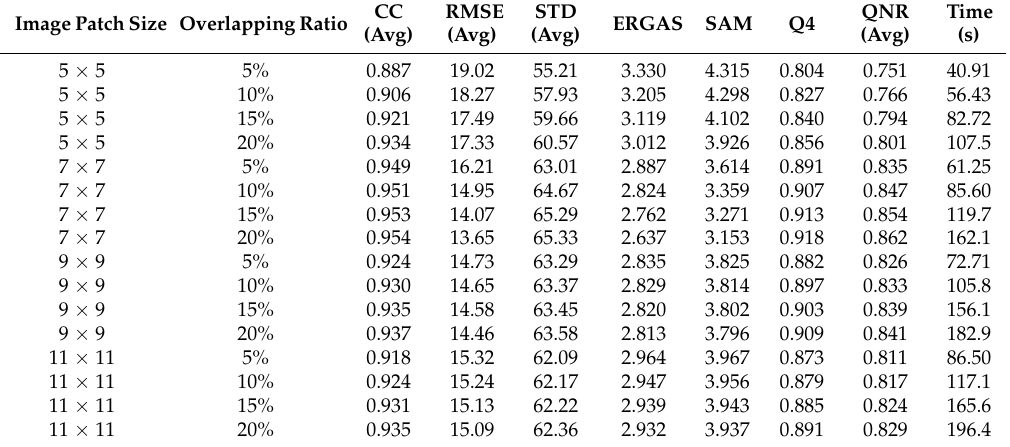
Table 6. Impact of image patch size and overlapping ratio on WorldView-2 image. Image Patch Size Overlapping Ratio